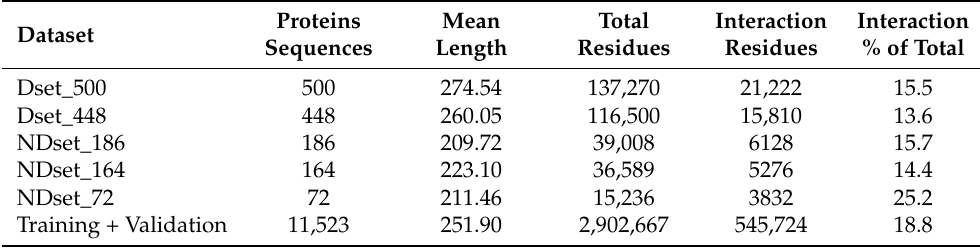
Table 3. Datasets